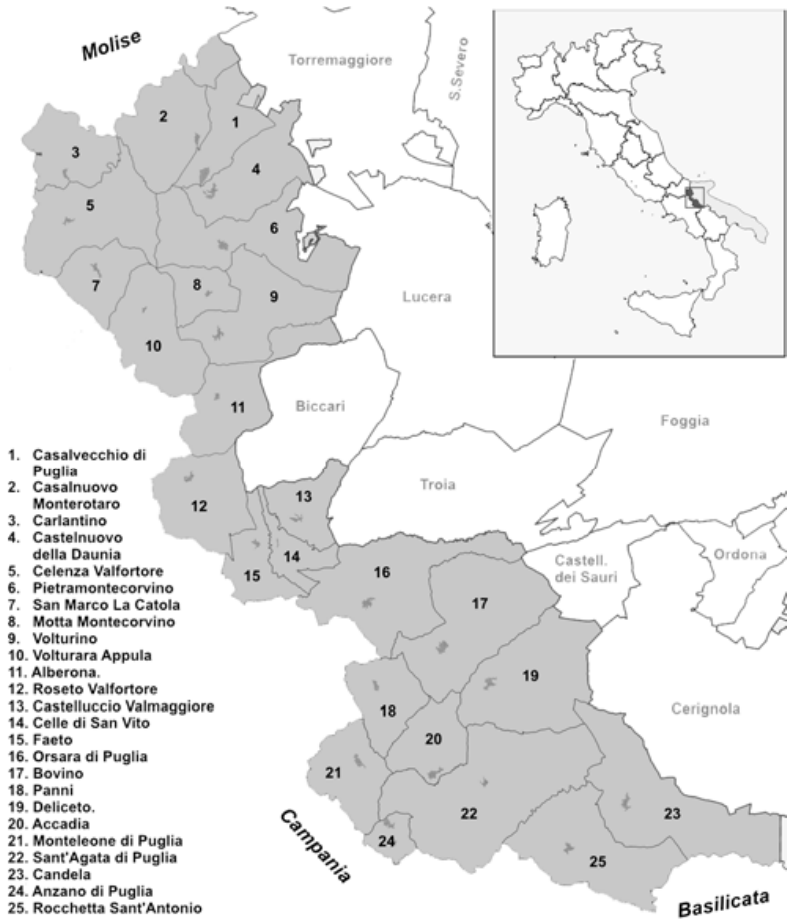
Fig. 1. Location map showing the administrative boundaries of the 25 small municipalities threatened by slope failure (Daunia Mts., Italian Apennines, Apulian sector).